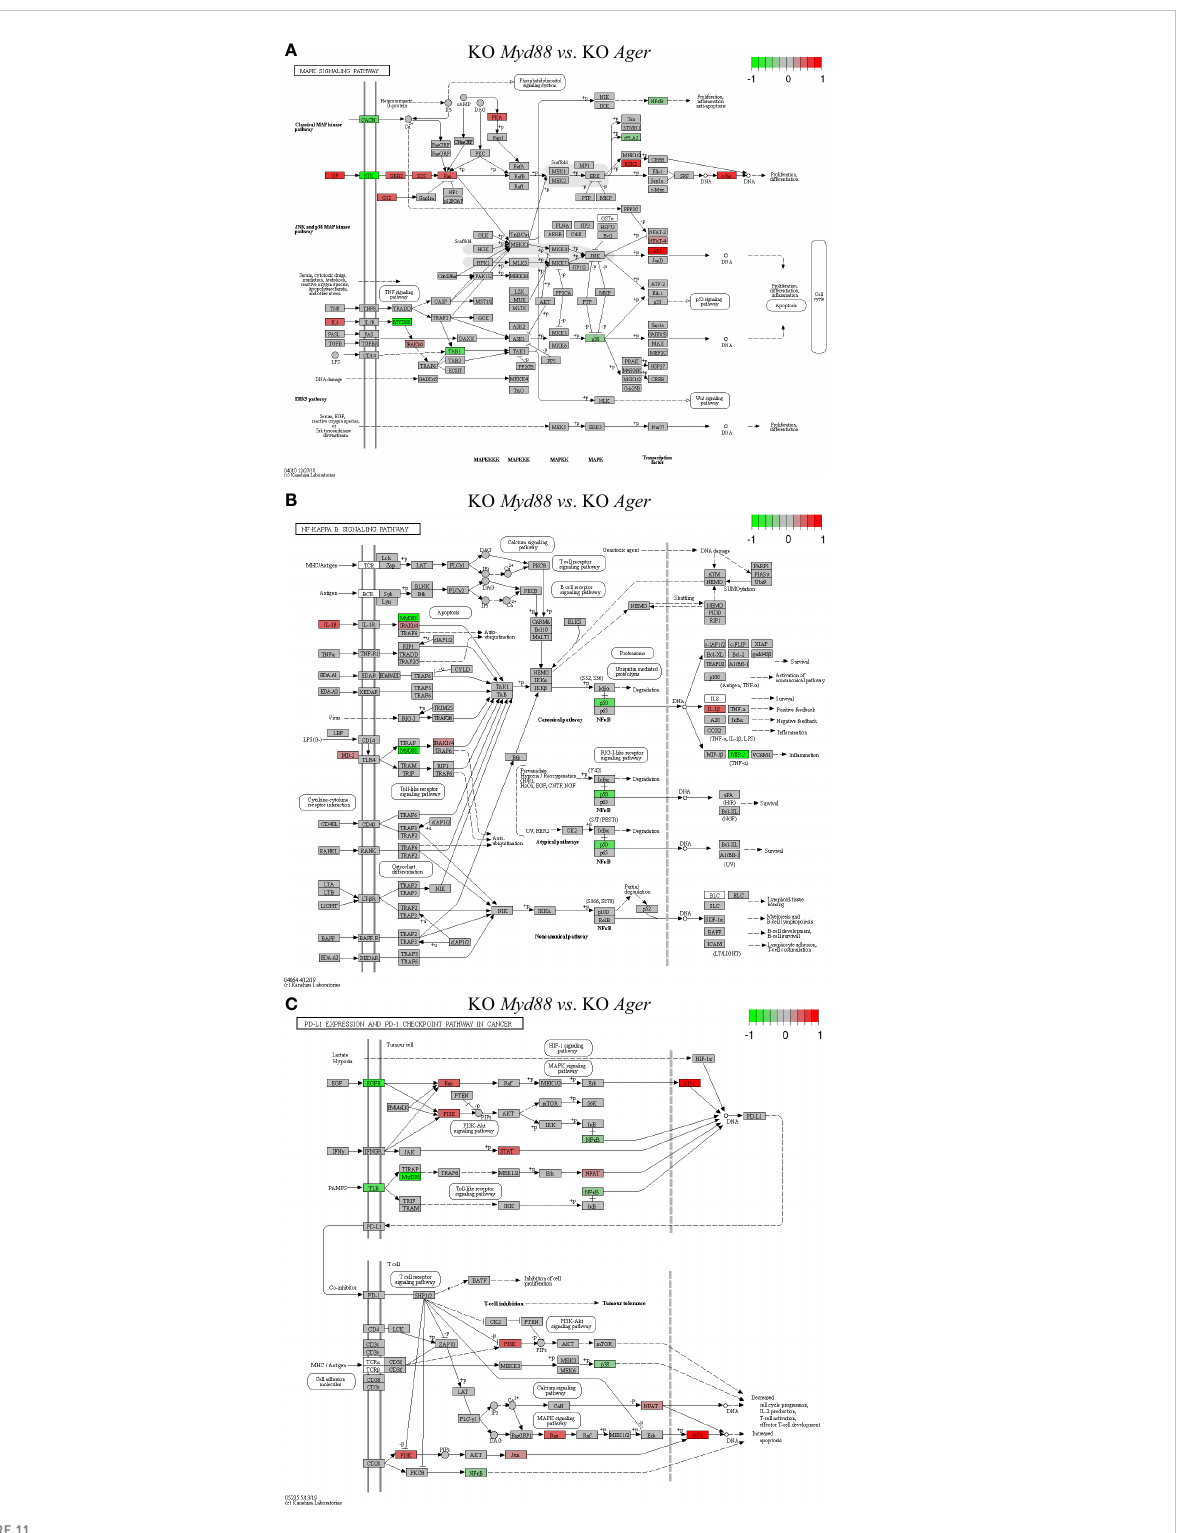
FIGURE 11 Comparison of the rendered target TPKO signaling pathways identi fi ed by the SPIA method from GSE22873_MvA (KO Myd88 vs. KO Ager). Explanations are presented in the main text. (A) The MAPK signaling pathway (mmu04010). (B) The NF-kappa B signaling pathway (mmu04064). (C) The PD-L1 expression and PD-1 checkpoint pathway in cancer